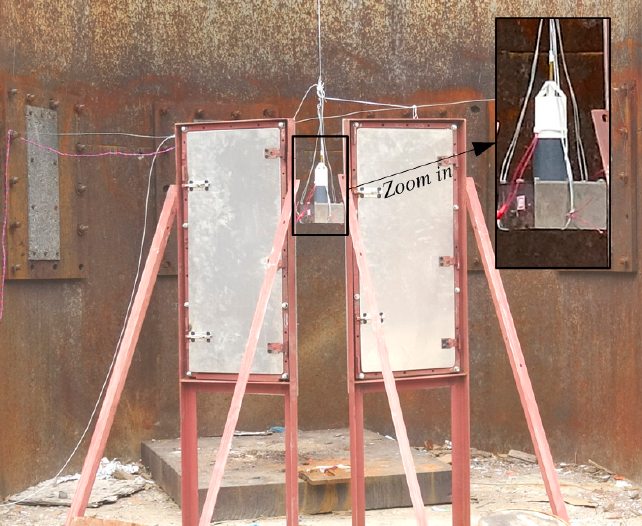
Figure 17. Schematic of the X-ray experiment layout.